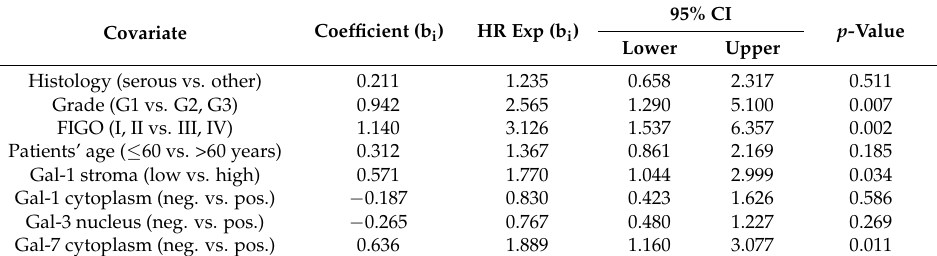
Table 2. Multivariate analysis.